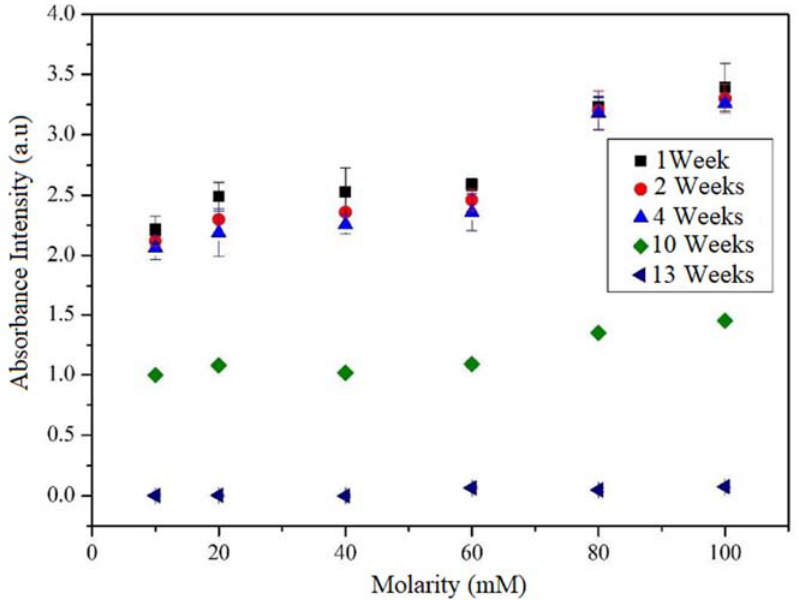
Figure 4. Evolution of the 300 nm absorbance peak depending on the number of weeks of MWCNT dispersion in water with different TX ‐ 100 molarities.